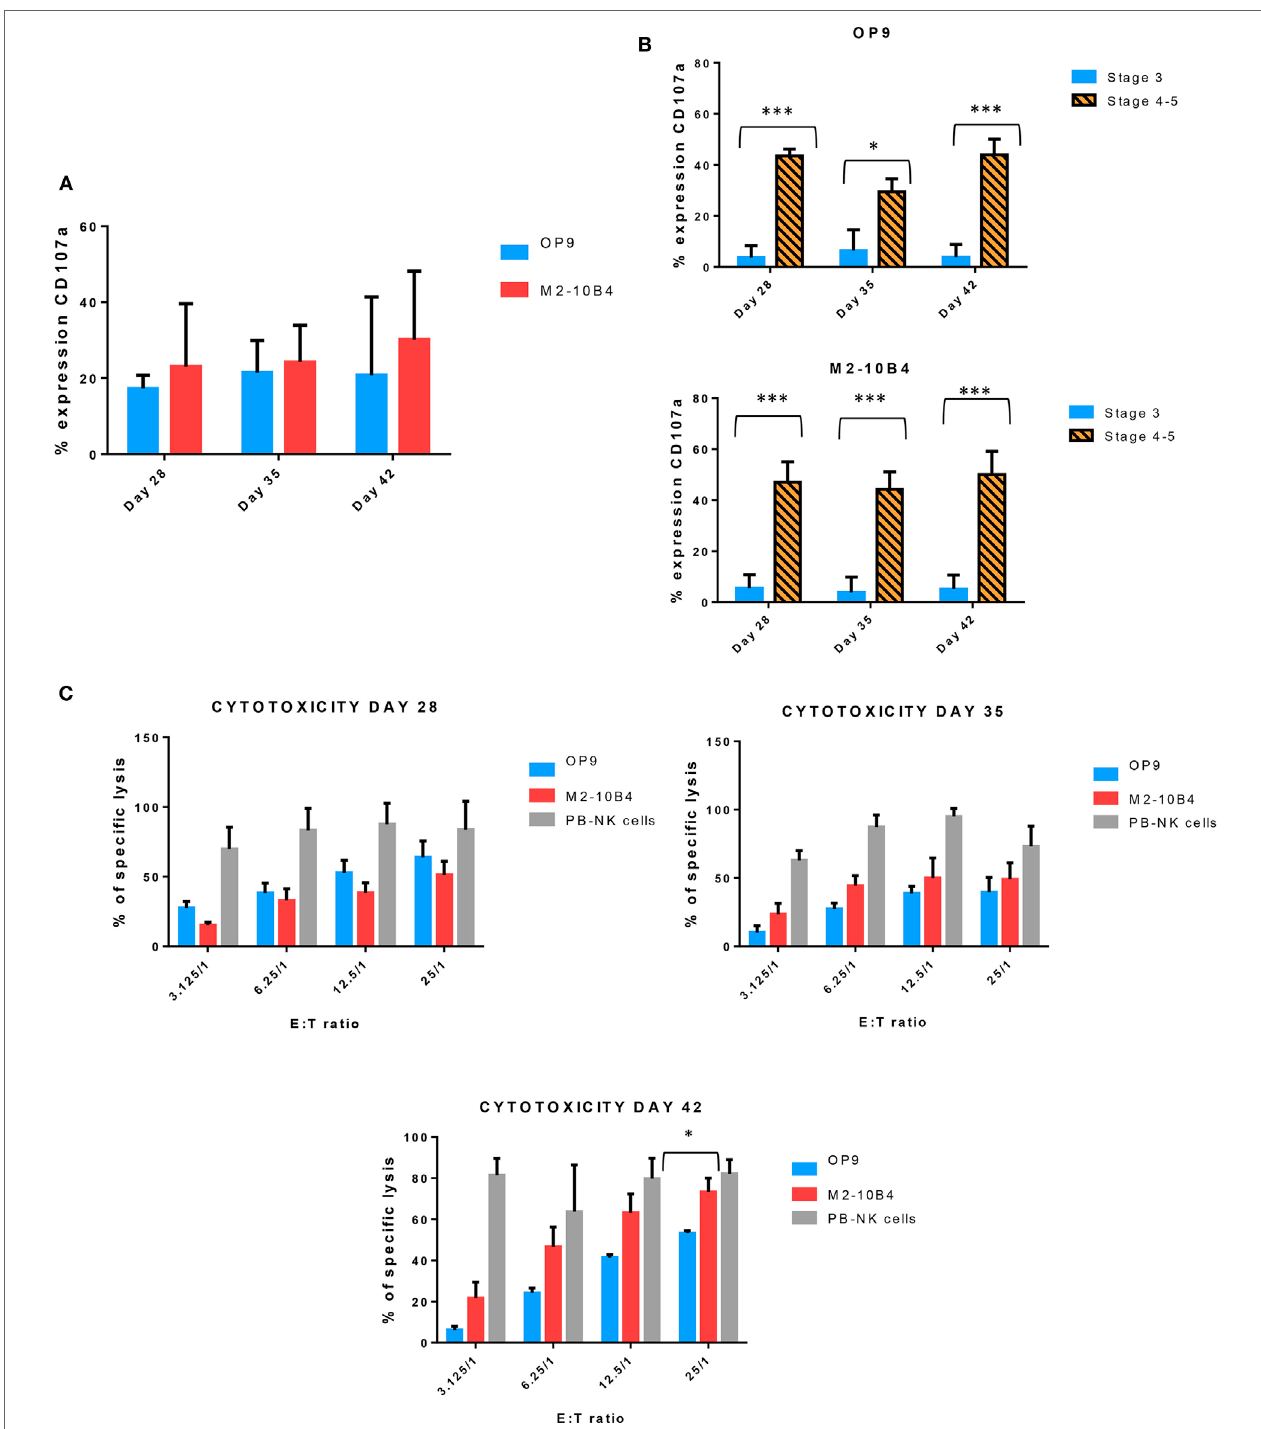
FigUre 4 | (a) Expression of CD107a, a marker of degranulation, in the in vitro -generated natural killer (NK) cells (CD56 + ) at different time points of the differentiation protocol in response to the stimulation with K562 target cells. (B) Expression of CD107a in both conditions (with OP9 and M2-10B4 feeder cell layers) at stage 3 and stages 4–5 at different times of the differentiation protocol. (c) Cytotoxicity activity of NK cells against K562 target cells at days 28, 35, and 42 of the differentiation protocol. Overnight cultured NK cells obtained from adult peripheral blood stimulated with the same cytokines as our in vitro -generated NK cells were used as a control. The bars represent the mean and error bars represent SEM. p -Value: * p < 0.05; *** p < 0.001. The absence of any asterisk indication means there are no significant differences ( Stage < 3 : CD56 − , CD94 − , CD117 low ; Stage 3 : CD56 + , CD94 − , CD16 − , CD117 high ; Stage 4: CD56 + , CD94 + , CD16 − , CD117 low , and Stage 5 : CD56 + , CD94 + , CD16 + , CD117 low ).